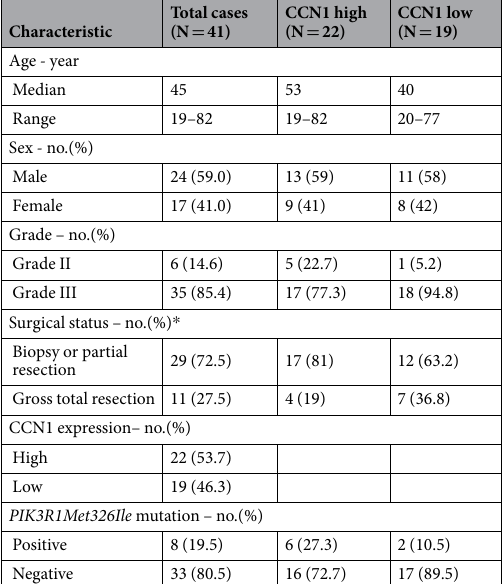
Table 3. Clinical and genetic characteristics of the astrocytoma study cohort. * We could not investigate the extension of resection of one patient.